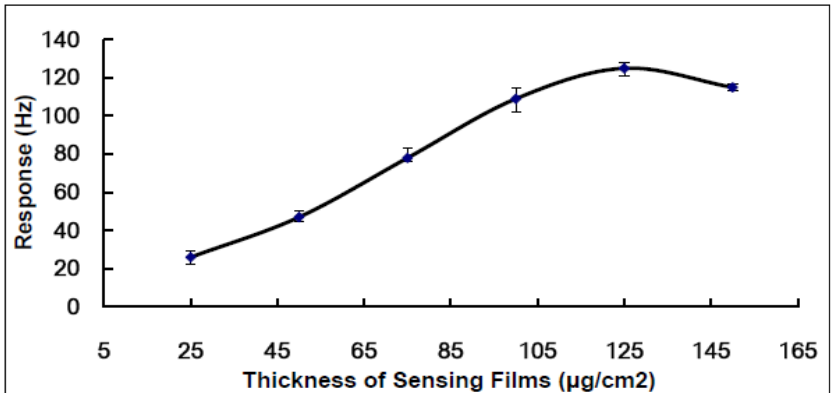
Figure 4. Responses of the QCM sensors with various thicknesses of sensing films to a predefined concentration of DMMP (0.7